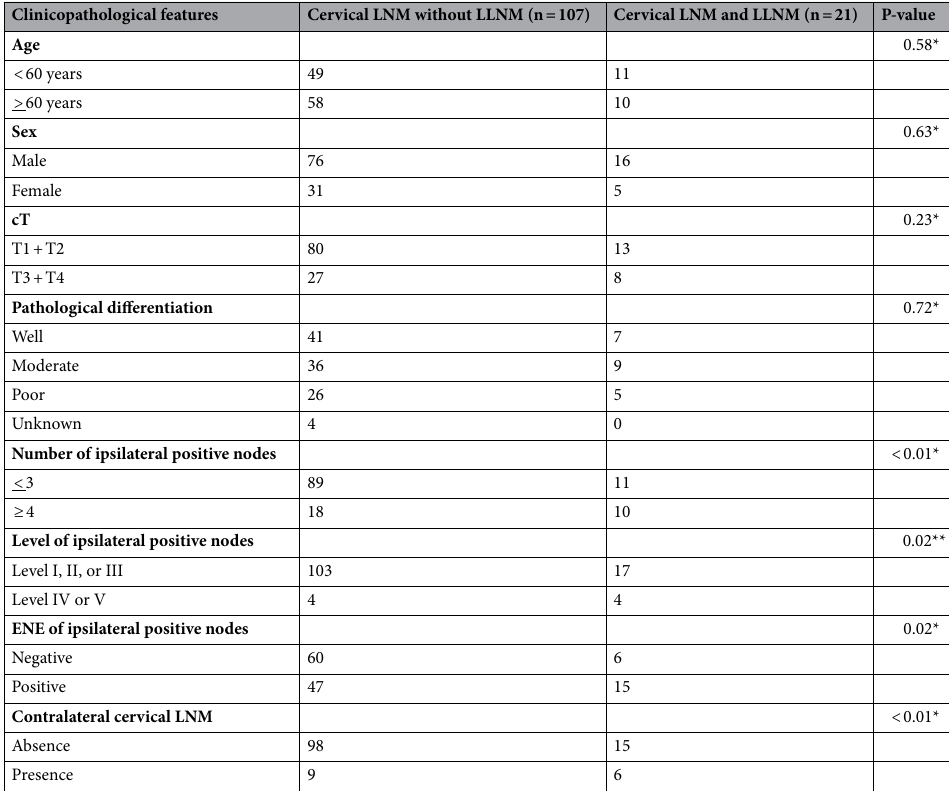
Table 1. Univariate analyses of correlation between clinicopathological features and LLNM in tongue SCC patients with lymph node metastases. SCC squamous cell carcinoma, LNM lymph node metastasis, LLNM lingual lymph node metastasis, ENE extranodal extension. *Chi-square test. **Fisher’s exact test. P < 0.05 is considered statistically significant in all